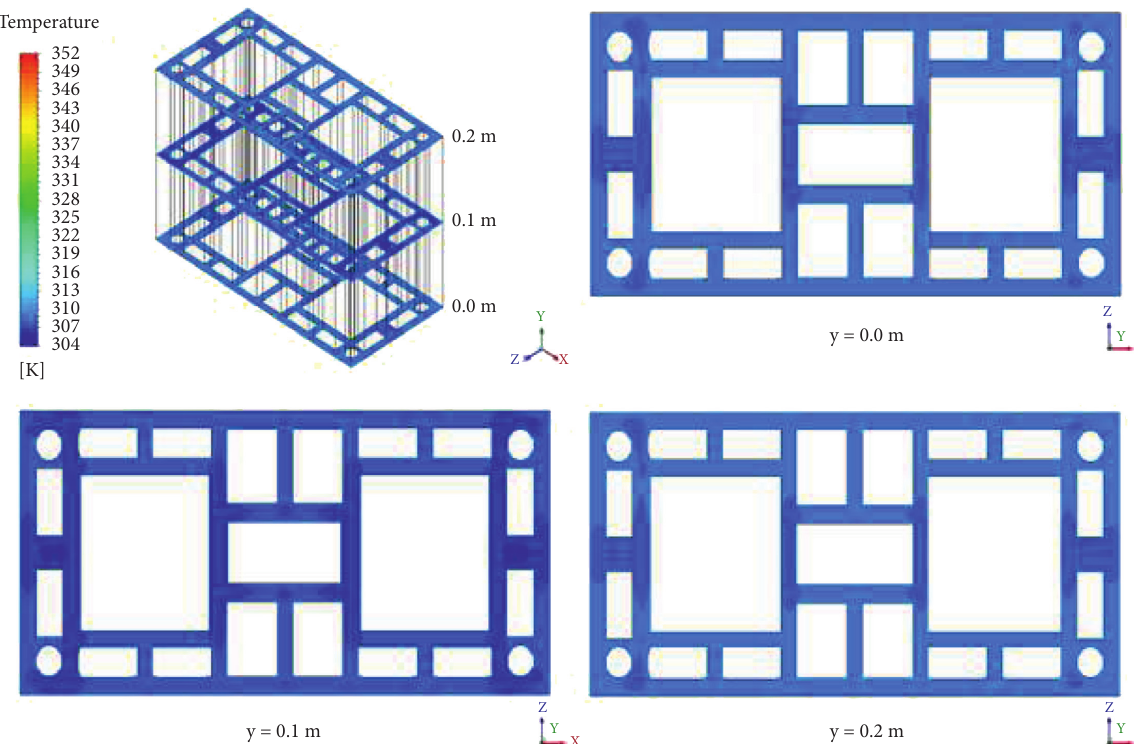
Figure 10: Temperature field inside the brick at different XZ planes, with the elapsed time of 10 minutes ( T � 80 ° C, RH � 5%).